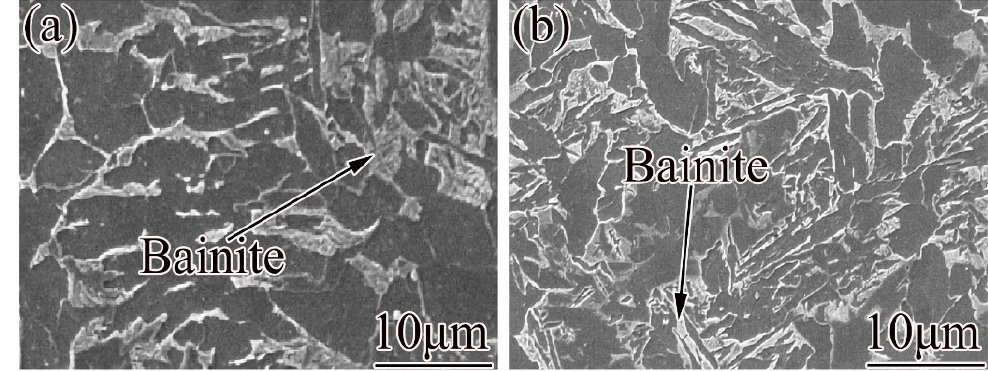
Figure 8. Bainite morphology of steel 2# at different cooling rates: ( a ) 1 °C/s, ( b ) 5 °C/s.